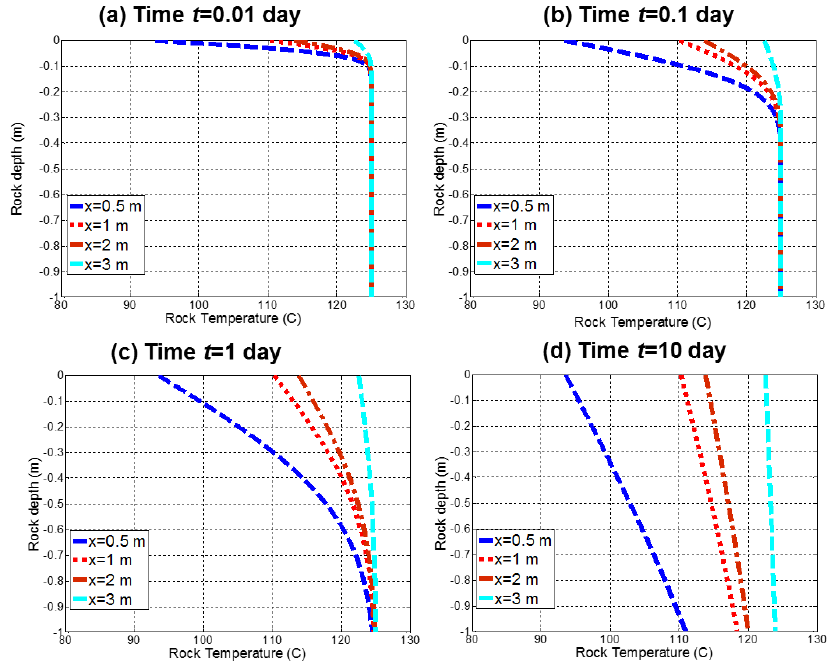
Figure 9. Cooling profile of the host rock at four locations ( x = [0.02, 0.04, 0.08, 0.12] (m)) for different times. ( a ) t = 0.01 day; ( b ) t = 0.1 day; ( c ) t = 1 day; ( d ) t = 10 days. Initial rock temperature is 125 °C. Fracture aperture is 0.005 m. Brine velocity is 0.001 m / s. The initial fracture wall temperature for time 0 is defined when first fresh injected fluid batch passes by. For example, for x = 0.002 m, the reference time is 0.02 / 0.001 = 20 s.